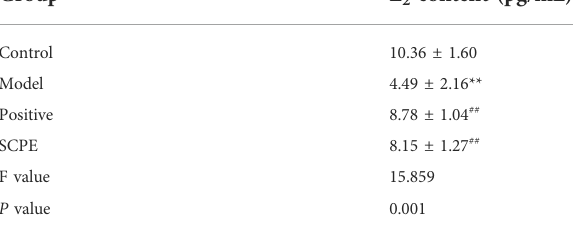
TABLE 5 E 2 content in mice (mean ± SD, n =